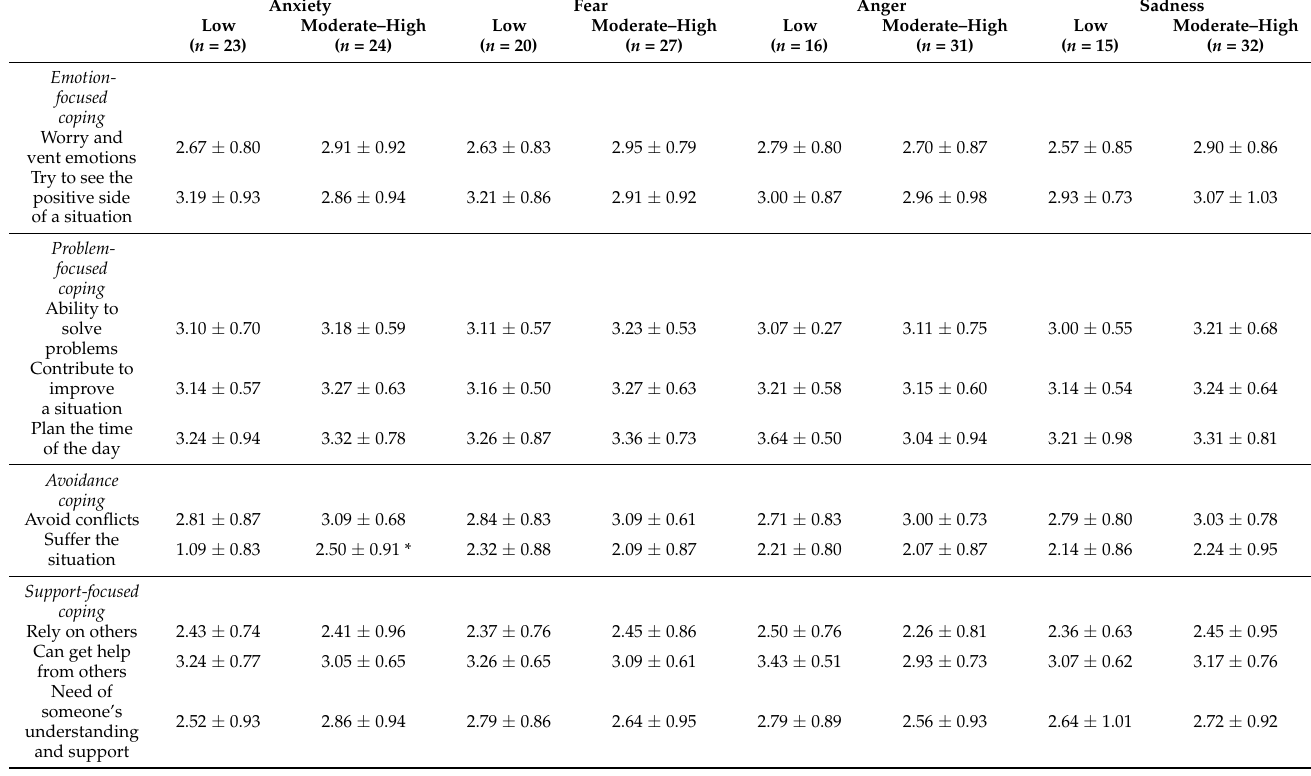
Table 6. Associations among emotional states and ways of